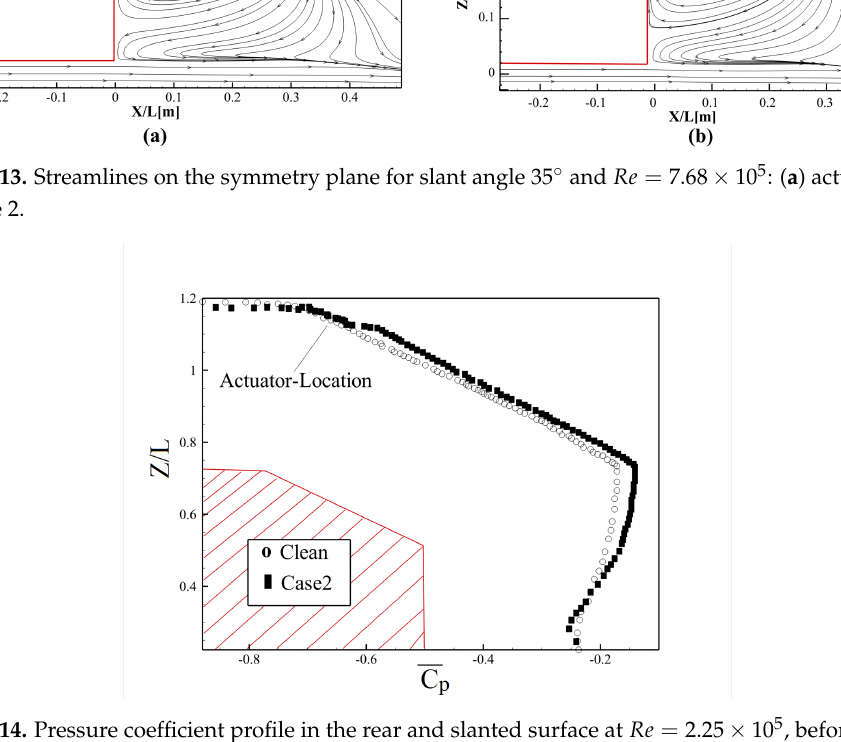
Figure 14. Pressure coefficient profile in the rear and slanted surface at Re = 2.25 × 10 5 , before (clean) and after (case 2) actuators.